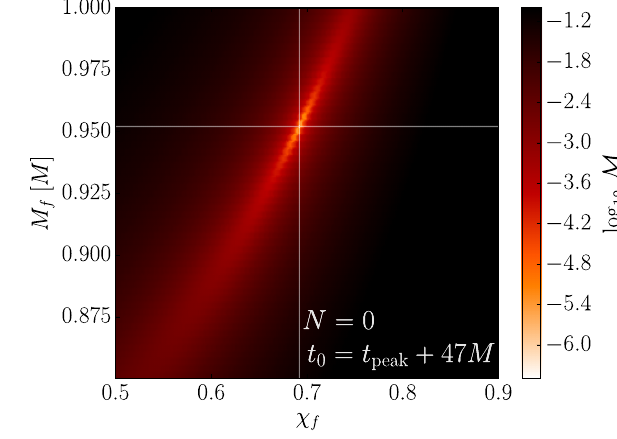
FIG. 4. Mismatches for the l ¼ m ¼ 2 mode between NR and Eq. (1) for a grid of M f and χ f with N ¼ 7 and t 0 ¼ t white horizontal and vertical lines correspond to the NR values and are in good agreement with the M f and χ f mismatch distribution using the maximum number of overtones considered.